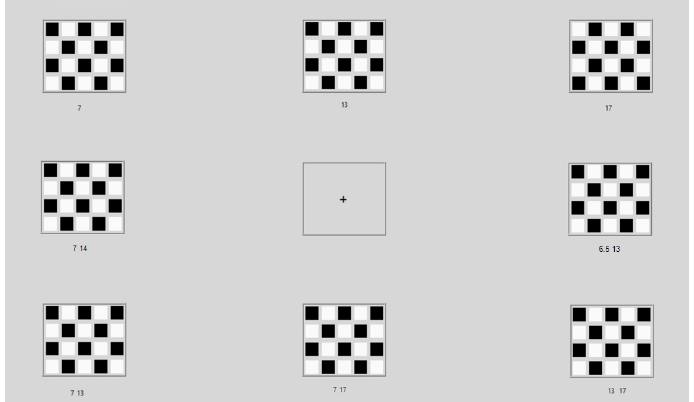
Figure 5. Screenshot conventional visual stimuli, using a checkerboard pattern with three funda- mental flickering frequencies and harmonics for eight different flicker patterns (Table 2), through an LCD monitor for SSVEP stimulation.